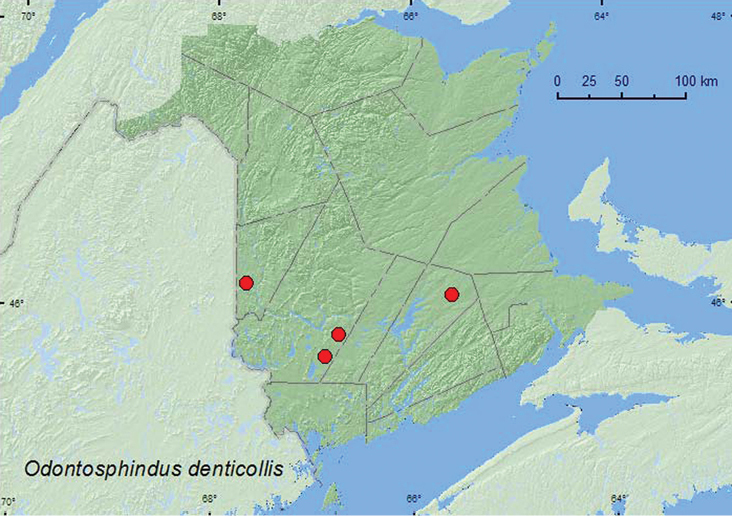
Collection localities in New Brunswick, Canada of Odontosphindus denticollis.